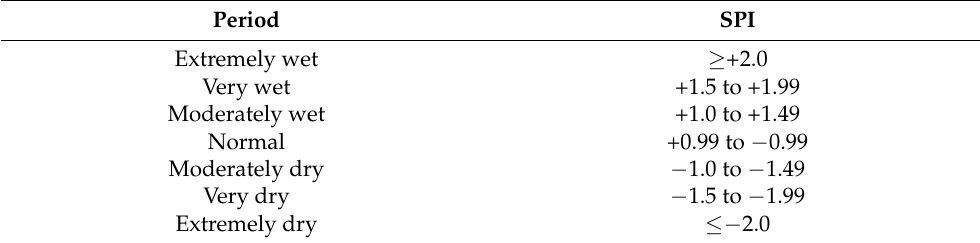
Table 2. Classes of drought and wet conditions based on SPI